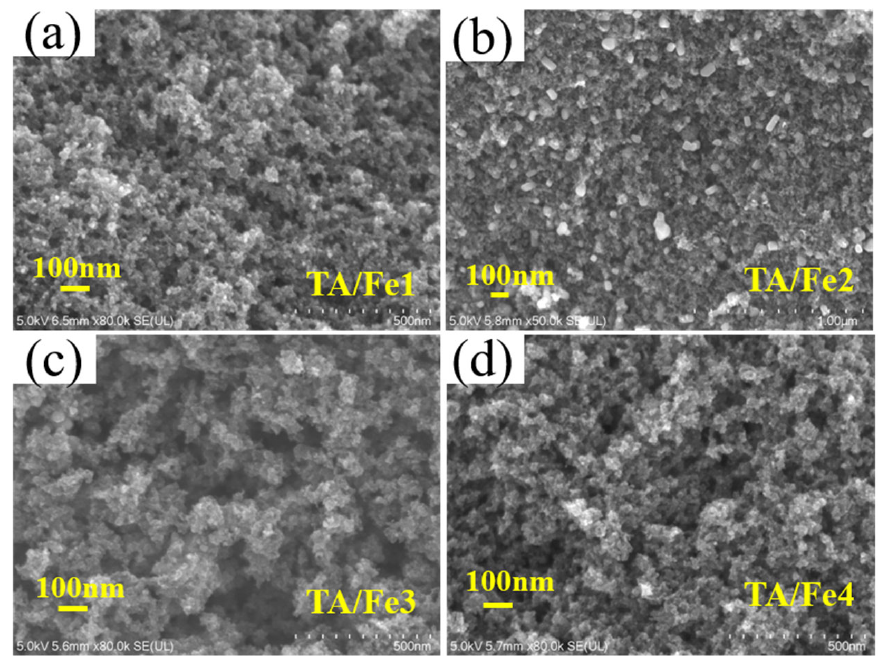
Figure 5. FESEM images of the Fe ‐ doped titanium oxide ‐ based aerogel catalysts.